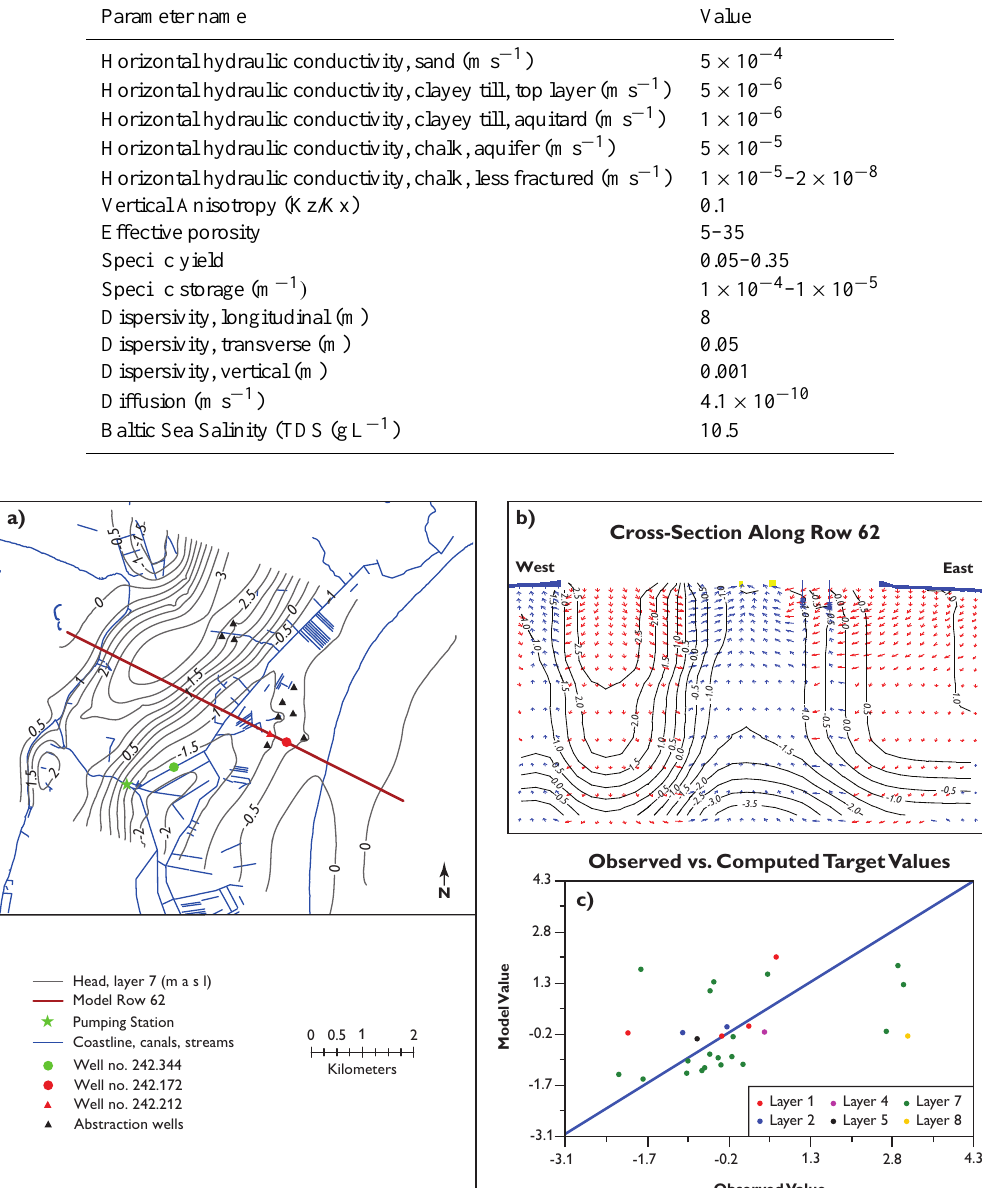
Fig. 7. (a) Groundwater head for main chalk aquifer 2010 situation, (b) flow velocity vectors for cross section model row 62 (see a ), (c) measured groundwater head versus modeled head